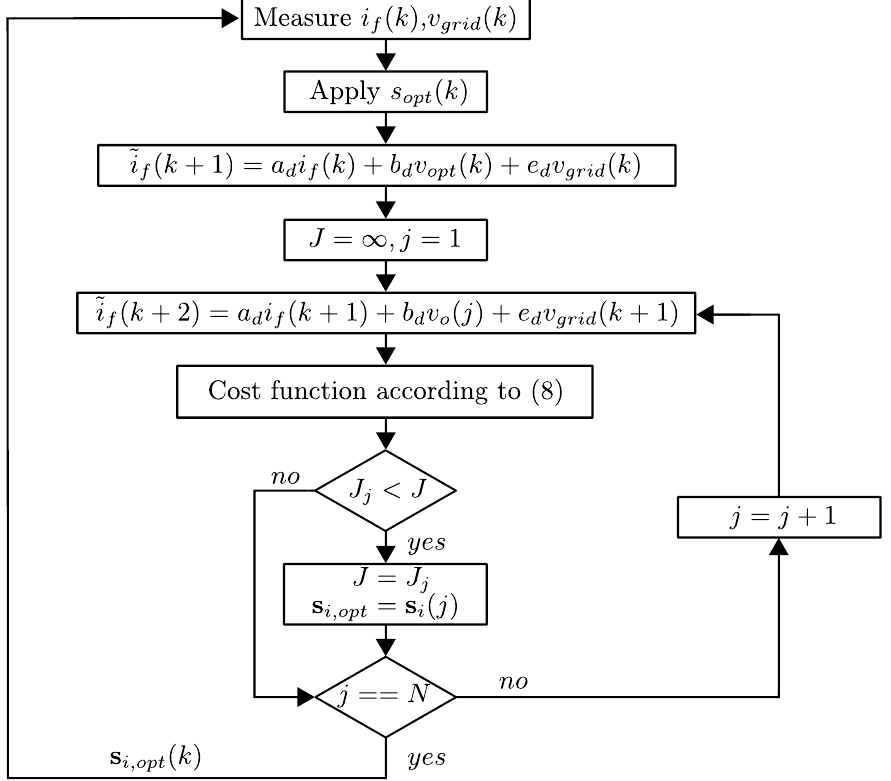
Figure 2. Conventional FCS-MPC flowchart applied to a grid-connected CHB